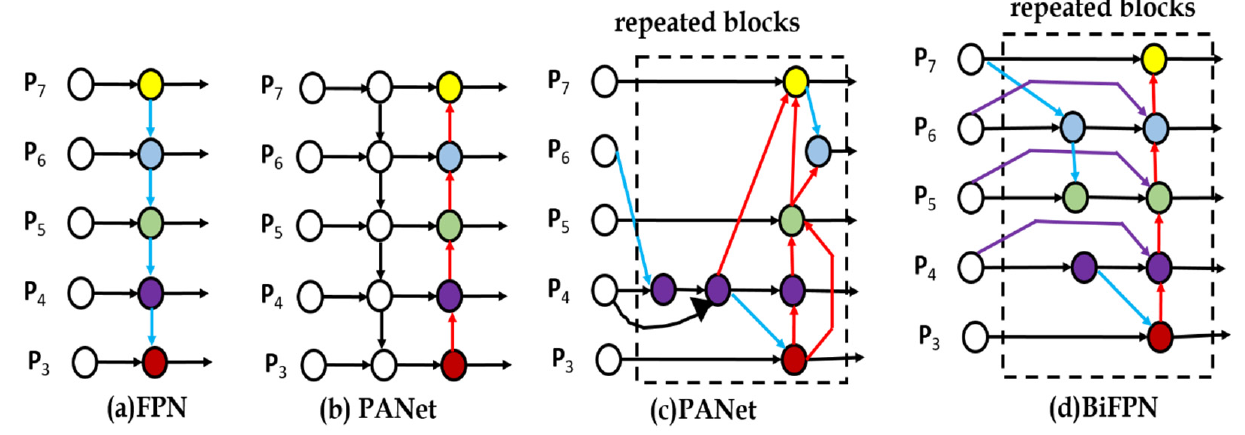
Figure 4. Different necks architecture [22].